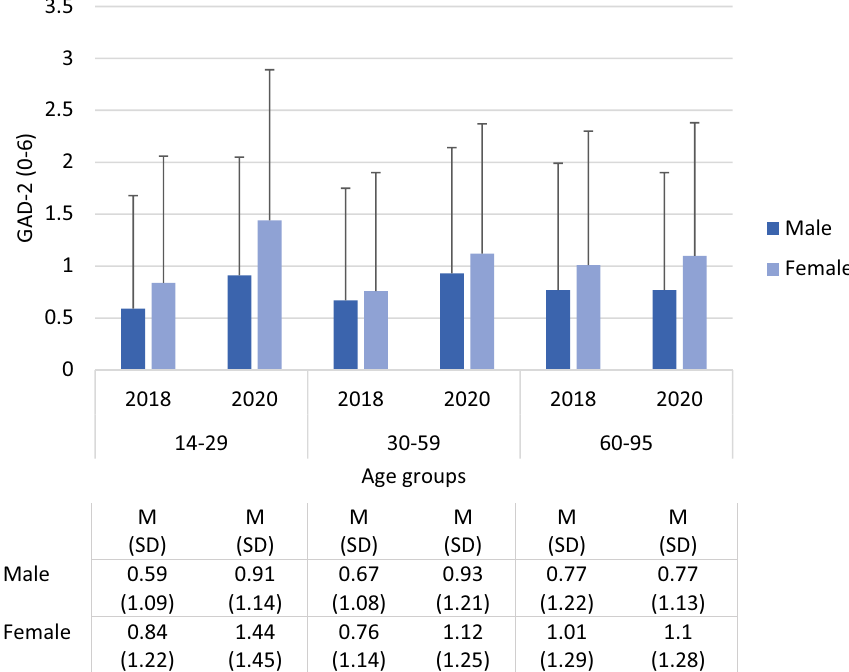
Figure 2. Anxiety scores in 2018 and 2020 by age group and sex. Analysis of variance: Survey (2018, 2020) by sex (male, female) by age group (14–29, 30–59, 60–95); F survey (df = 1) = 62.21, p < .001; F Sex (df = 1) = 44.02, p < .001; F age group (df = 2) = 2.27, p = .10; F survey by sex (df = 1) = 4.06, p = .04; F survey by age group (df = 2) = 13.41, p < .001; F sex by age group (df = 2) = 6.59, p = .013.